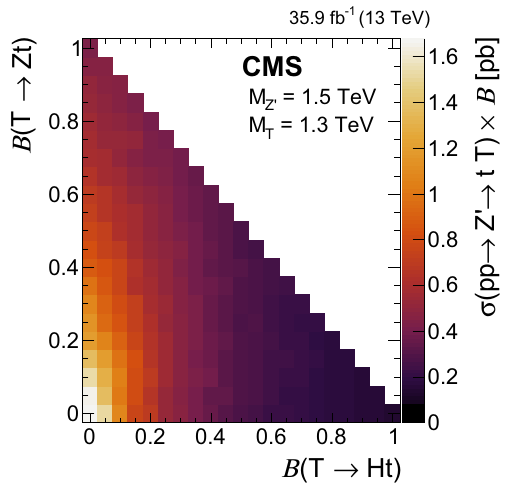
Fig. 9 Model-independent observed exclusion limits at 95% CL on the product of the cross section and branching fraction B = B ( T → Wb ) + B ( T → Ht ) + B ( T → Zt ) for an example mass configuration of M Z (cid:3) = 1 . 5TeV and M T = 1 . 3TeV as a function of the branching fractions B ( T → Ht ) and B ( T → Zt